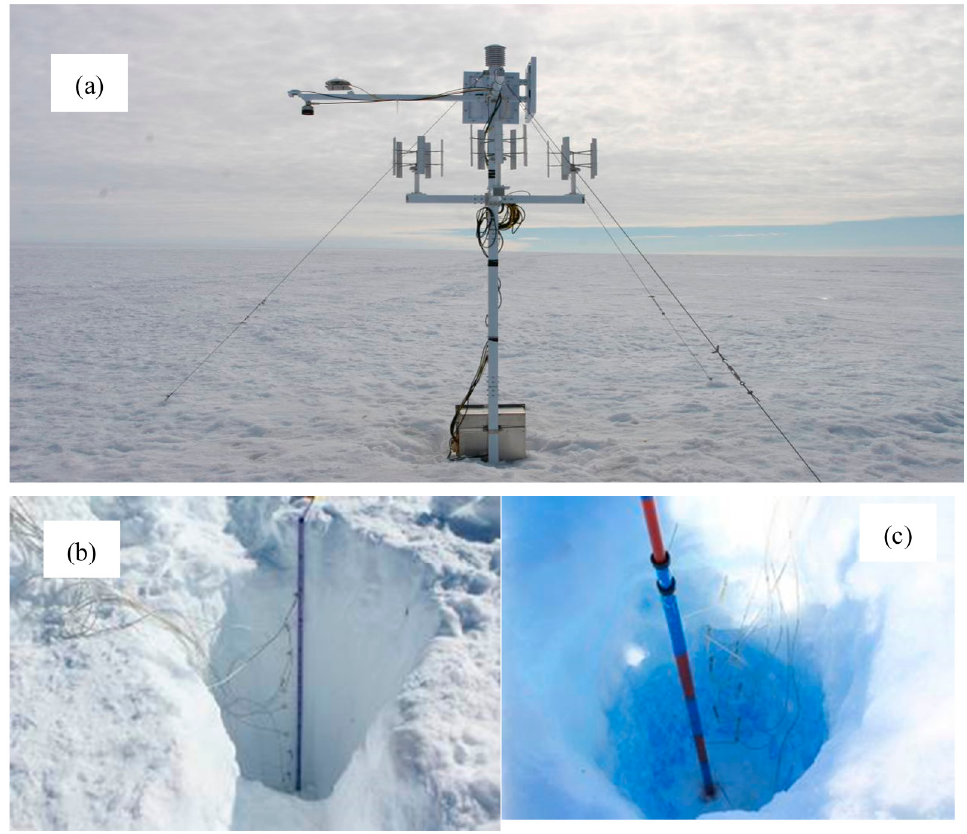
Figure 5. Field installation of the wireless sensor network observing platform (( a ) the overall effect of the model machine field installation; ( b ) placing of the nine tiers of snow temperature sensors; ( c ) a temperature sensor is placed every 10 cm under the snow surface).